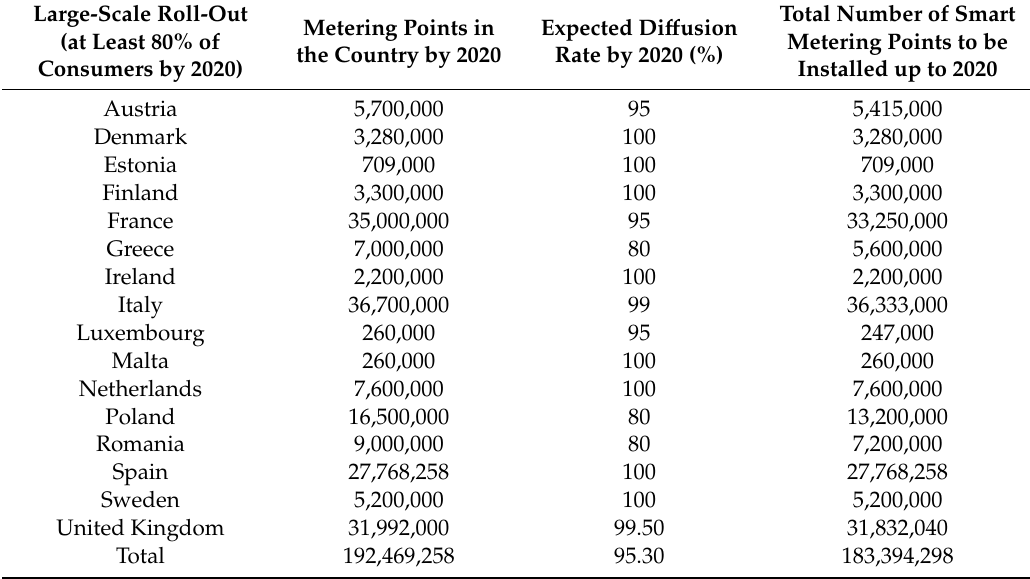
Figure 3. Decisions of EU MSs to start smart meter roll-out, as a result of cost-benefit analyses in 2014. Reproduced under CC BY 4.0, European Commission Joint Research Centre. Smart Metering Deployment in the European Union 2019. Available online: https://ses.jrc.ec.europa.eu/smart-metering-deployment-european-union (accessed on 15 April 2019). Table 5. Number of electricity smart meters to be installed per Member State that are proceeding with large-scale roll-out. Reproduced under CC BY 4.0, European Commission. SWD(2014) 189 Final. Cost-Benefit Analyses & State of Play of Smart Metering Deployment in the EU-27; Brussels: European Commission,